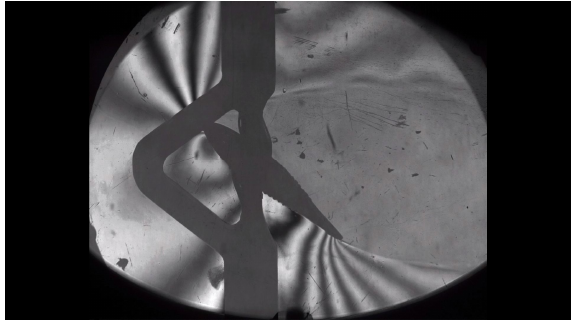
Fig. 13d. Interferogram, airfoil at maximal positive